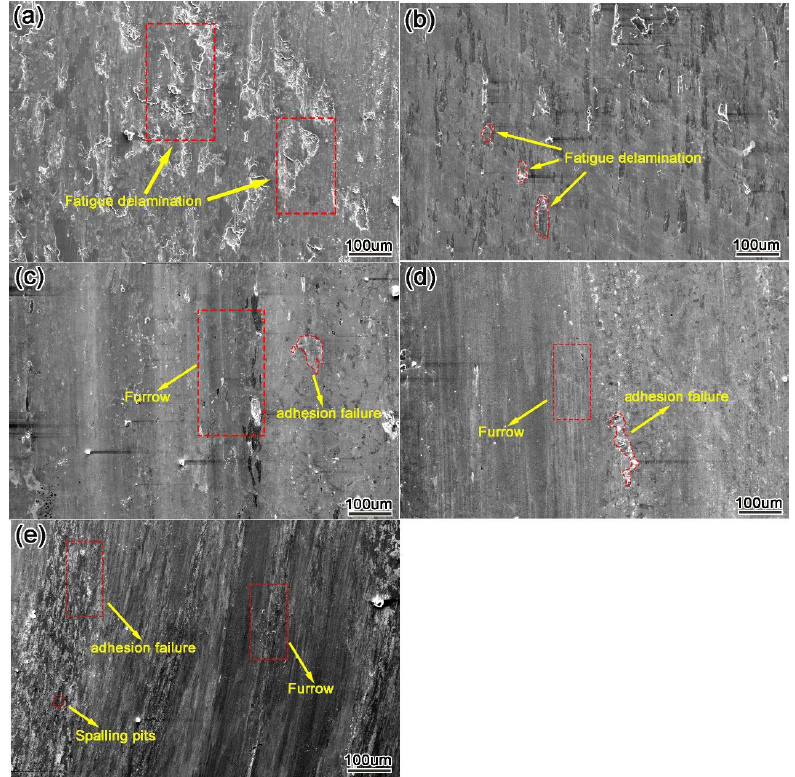
Figure 14. Wear morphology of modified surfacing layer with different contents of Y 2 O 3 ( a ) 0 wt.%, ( b ) 0.4 wt.%, ( c ) 0.8 wt.%, ( d ) 1.2 wt.%, and ( e ) 1.6 wt.%.